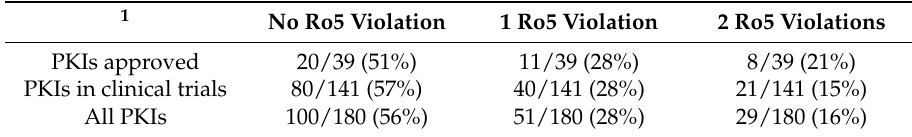
Table 1. Comparison of Lipinski’s rules violation between approved and in clinical trials